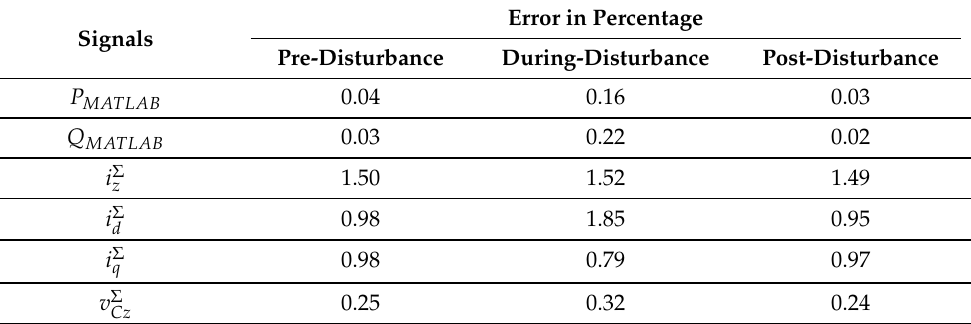
Table 4. MAE in the mathematical model during the step change in Reactive Power from 0 p.u. to 0.24 p.u. at t = 0.6 s.